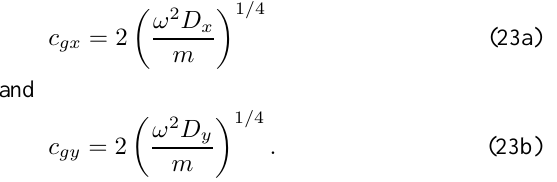
Fig. 16. The approximate energy density distribution of the orthotropic plate when f = 5 kHz and η = 0 . 2 . The reference energy density is 1 × 10 − 12 J/m 2